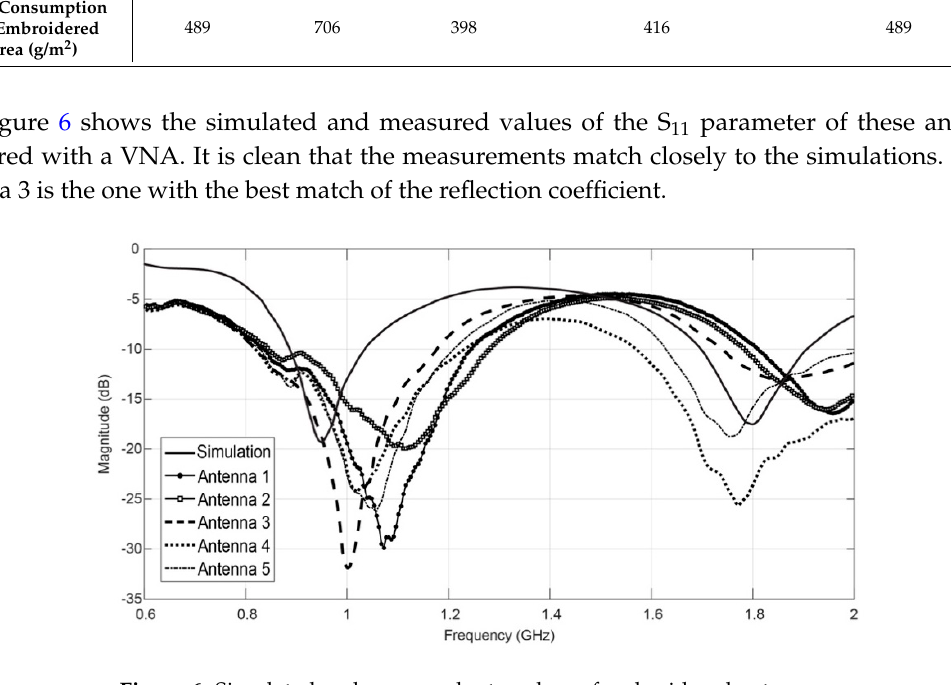
Figure 6. Simulated and measured return loss of embroidered antennas.